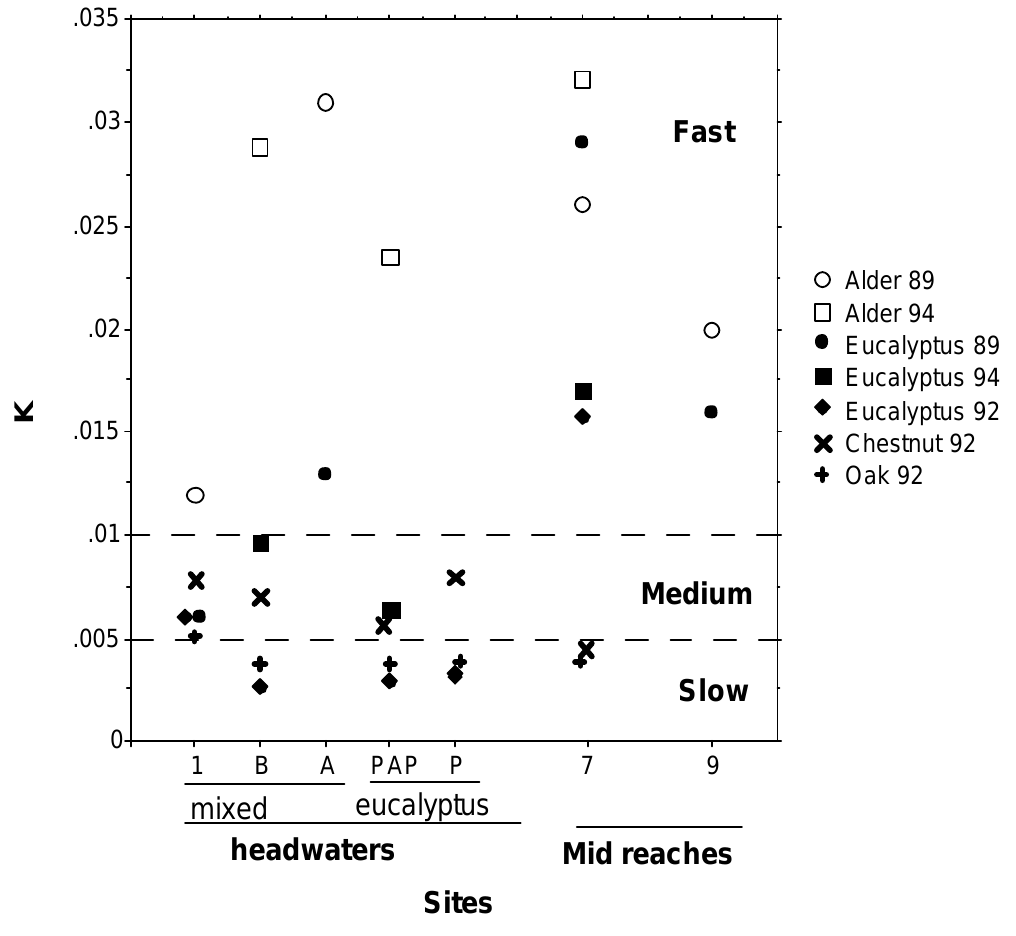
FIGURE 2. Breakdown rates of different leaf species incubated in headwaters and mid reaches of the Agüera stream (Spain). Note that while native deciduous leaves decay at reasonably constant, species-specific rates, irrespective of site and year, Eucalyptus are the slowest species in nutrient-poor headwater reaches, and among the fastest in nutrient-rich mid